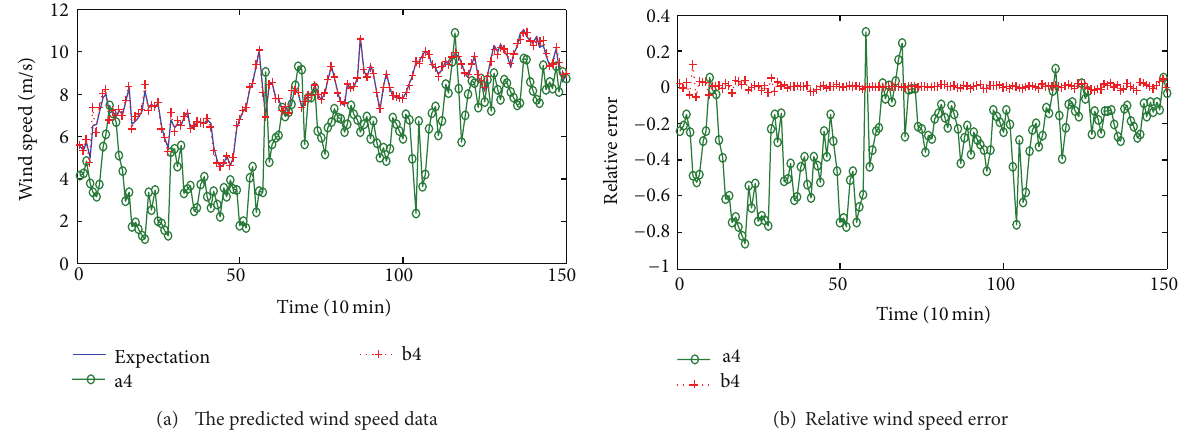
Figure 4: The effect comparison between a4 and b4.